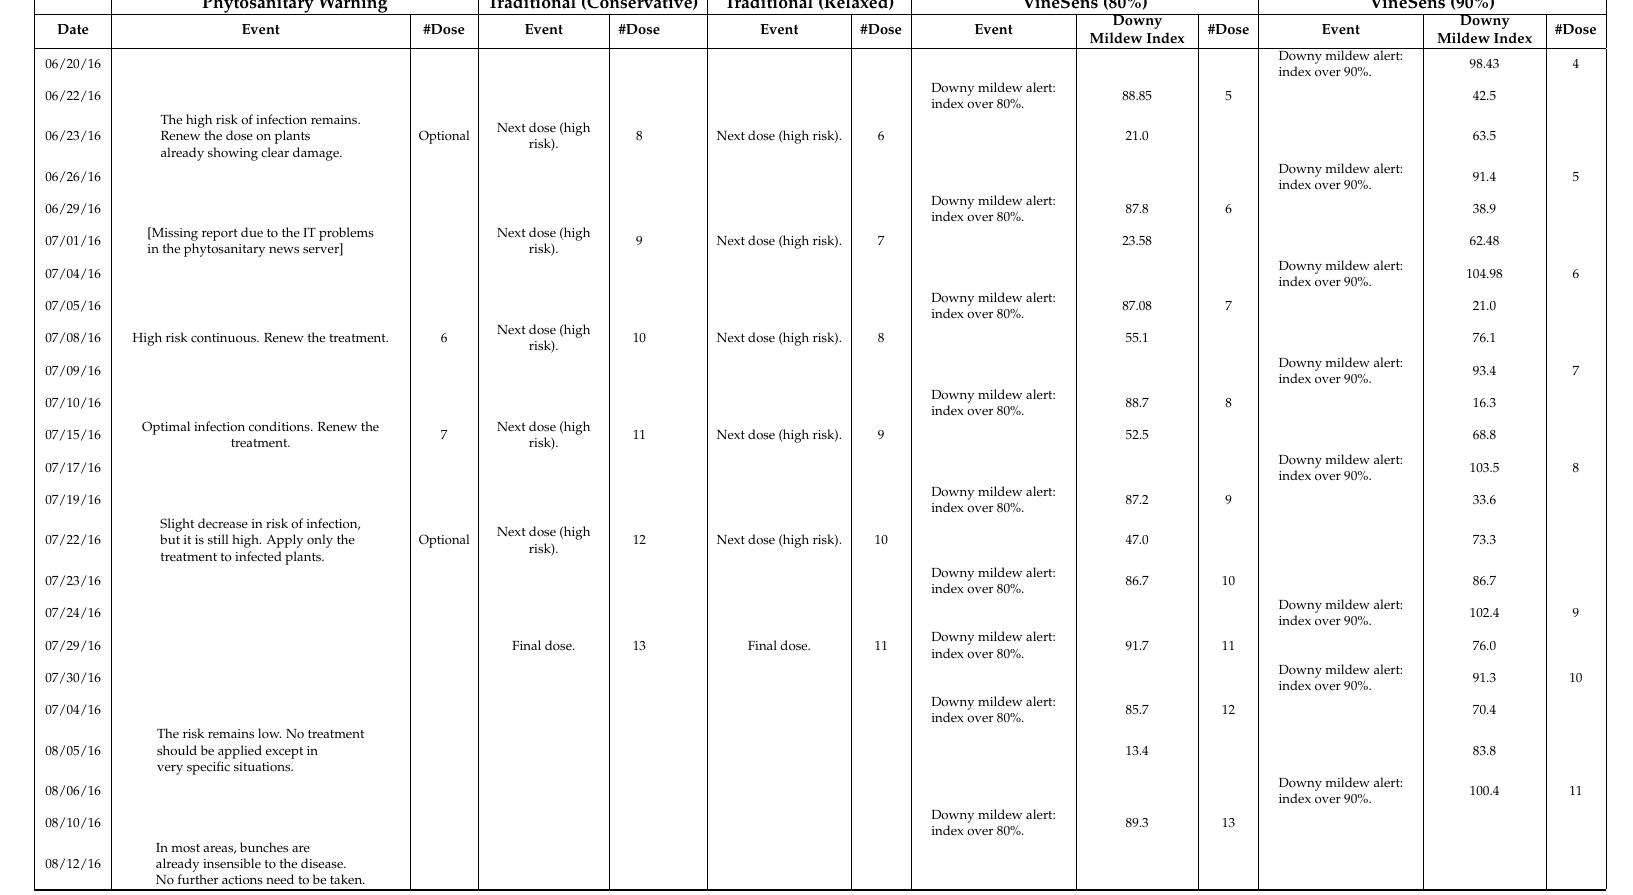
Table 7. Traditional downy mildew prevention methods versus VineSens (second